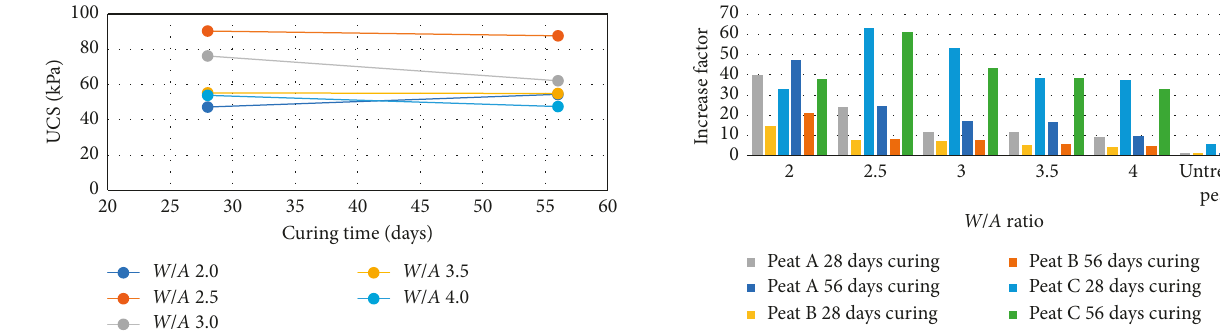
Figure 11: UCS value increase factor vs. W / A ratio for each